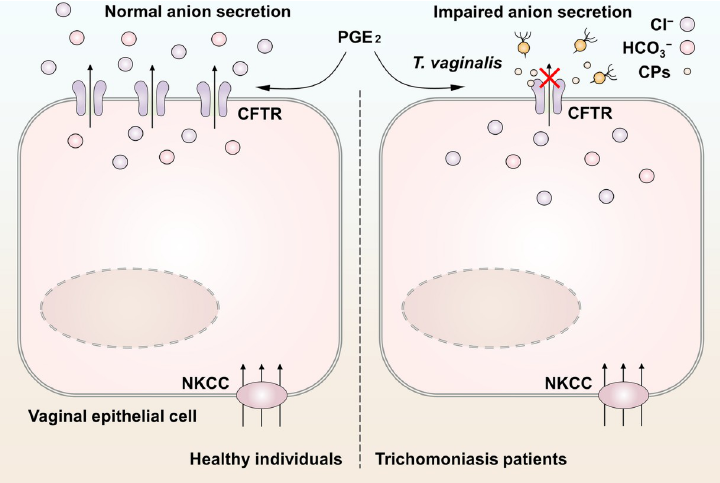
Fig 5. Schematic model of the impaired anion secretion triggered by Trichomonas vaginalis infection in vaginal epithelium. Seminal prostaglandin E 2 (PGE 2 ) facilitated anion secretion by activating cystic fibrosis transmembrane conductance regulator (CFTR) in vaginal epithelium. The basolateral Na + -K + -2Cl − cotransporter (NKCC) guaranteed the maintenance of steady anion secretion by supplying Cl − . After T . vaginalis infection, the CFTR was markedly down-regulated via cysteine proteases secreted by the pathogens, which restrained the exogenous PGE 2 -induced anion secretion. This may be a cause of the abnormal vaginal fluid microenvironment in patients with trichomoniasis.